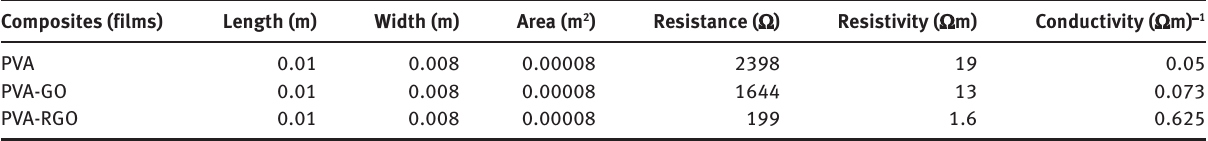
Table 3: Resistance, resistivity, and conductivity of the samples [82]. Composites